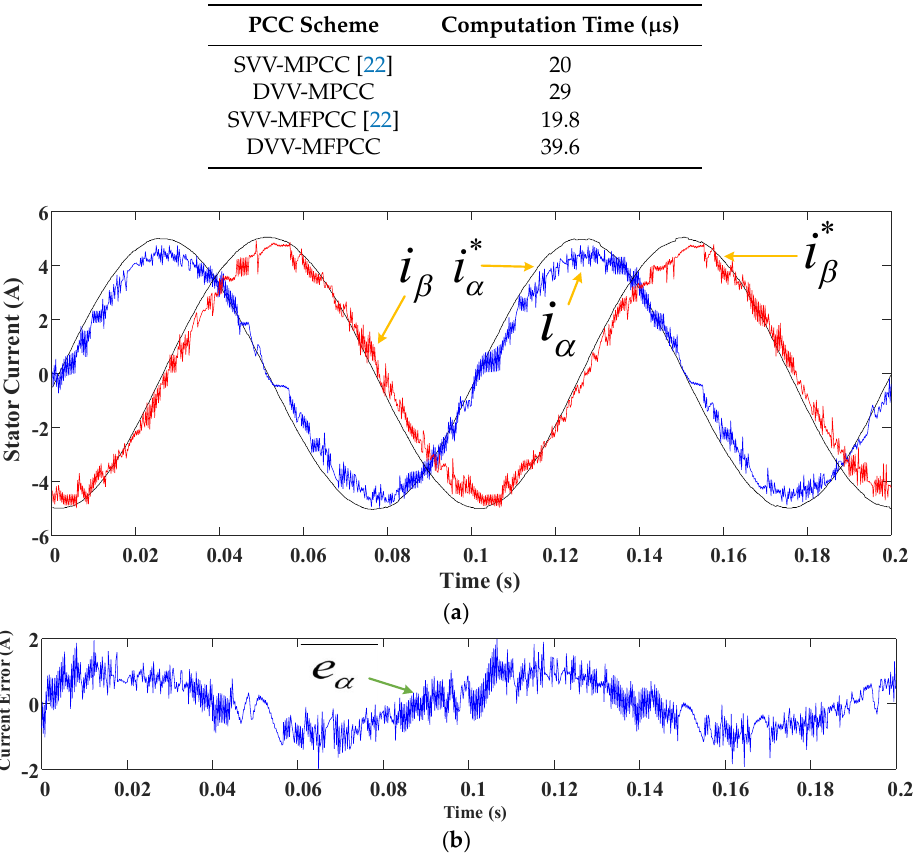
Table 5. Computation time for different schemes using the microcontroller TMS320F28377S.